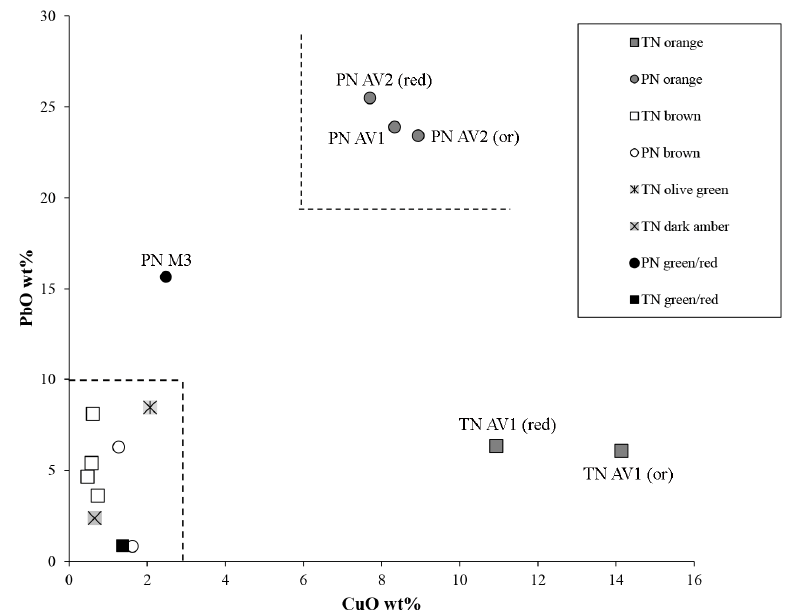
Figure 15. PbO vs CuO bi-plot of red tesserae; olive-green tessera TN VOL2 is also included (see text for details). Dotted lines mark the low-copper/low-lead and high-copper/high-lead fields according to Freestone et al. [15].